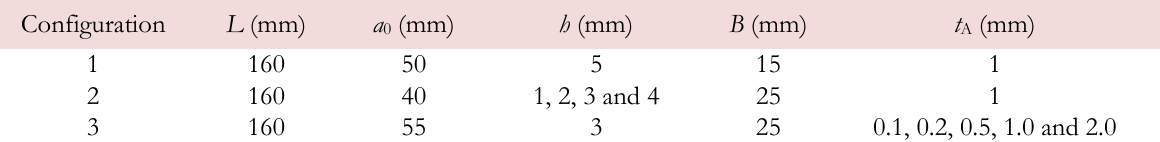
Table 2: Dimensions of the three joint